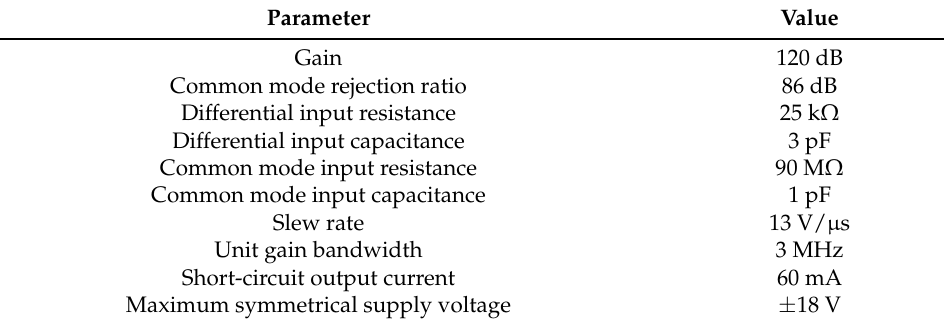
Table 3. Parameter values of the operational amplifier model